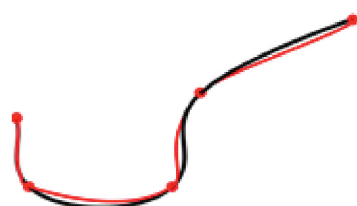
Figure 8: Cubic spline fitted for 2nd iteration of GA.